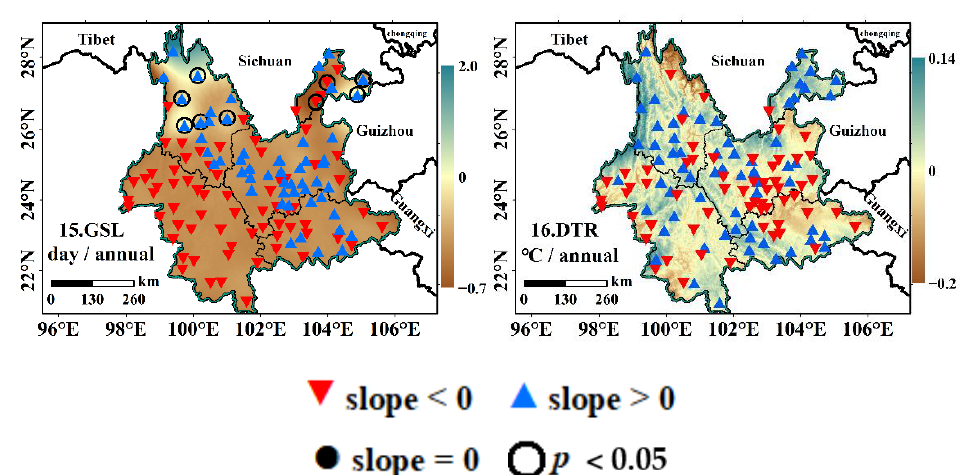
Figure 3. Spatial distribution of extreme temperature indices variation trend in Yunnan. Notes: The red triangles indicate that the trend coefficient of the weather station is less than 0. The blue triangles indicate that the trend coefficient of the weather station is greater than 0. The solid black circles indicate that the trend coefficient of the weather station is 0. The hollow black circle indicates that the trend coefficient of the meteorological station passes the significance test of p = 0.05. Space filling was carried out through ANUSPLIN method.